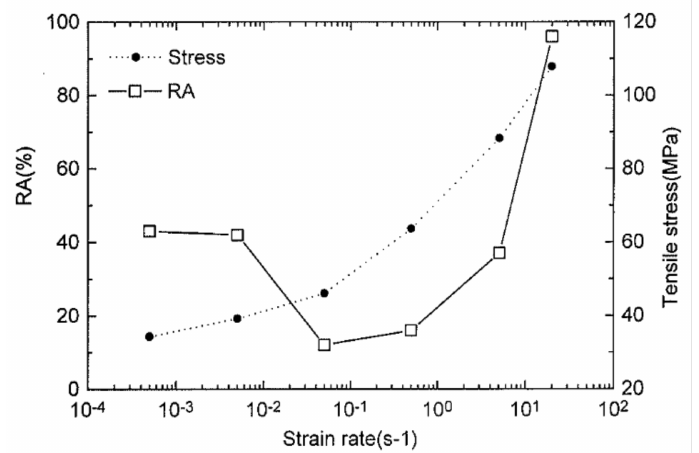
Figure 6. Reduction of area (RA) as a function of strain rate, showing strain rate embrittlement, measured at 1373 K for an Fe-36Ni alloy doped with Cu. Reprinted from ref.